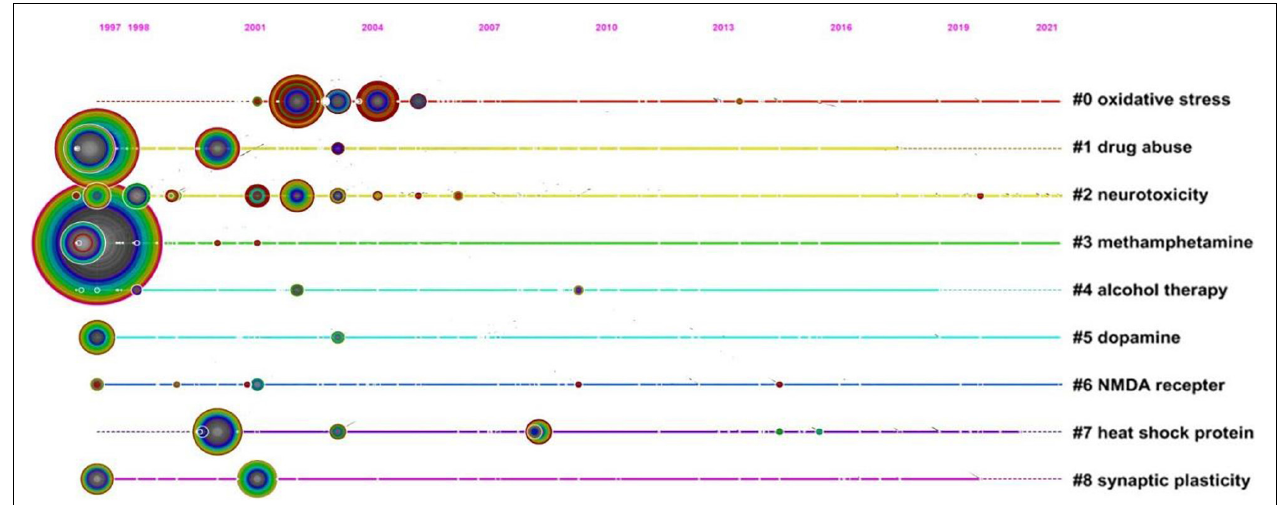
FIGURE 5 | Co-cited references timeline map of neurotoxicity of substance abuse. Nodes represent referenced documents. The size of nodes represents the frequencies of cited references, and the location reflects the present time. Years are arranged horizontally at the top. The clusters are performed based on the themes of co-cited references and the label of each cluster is shown at the end of the timeline.